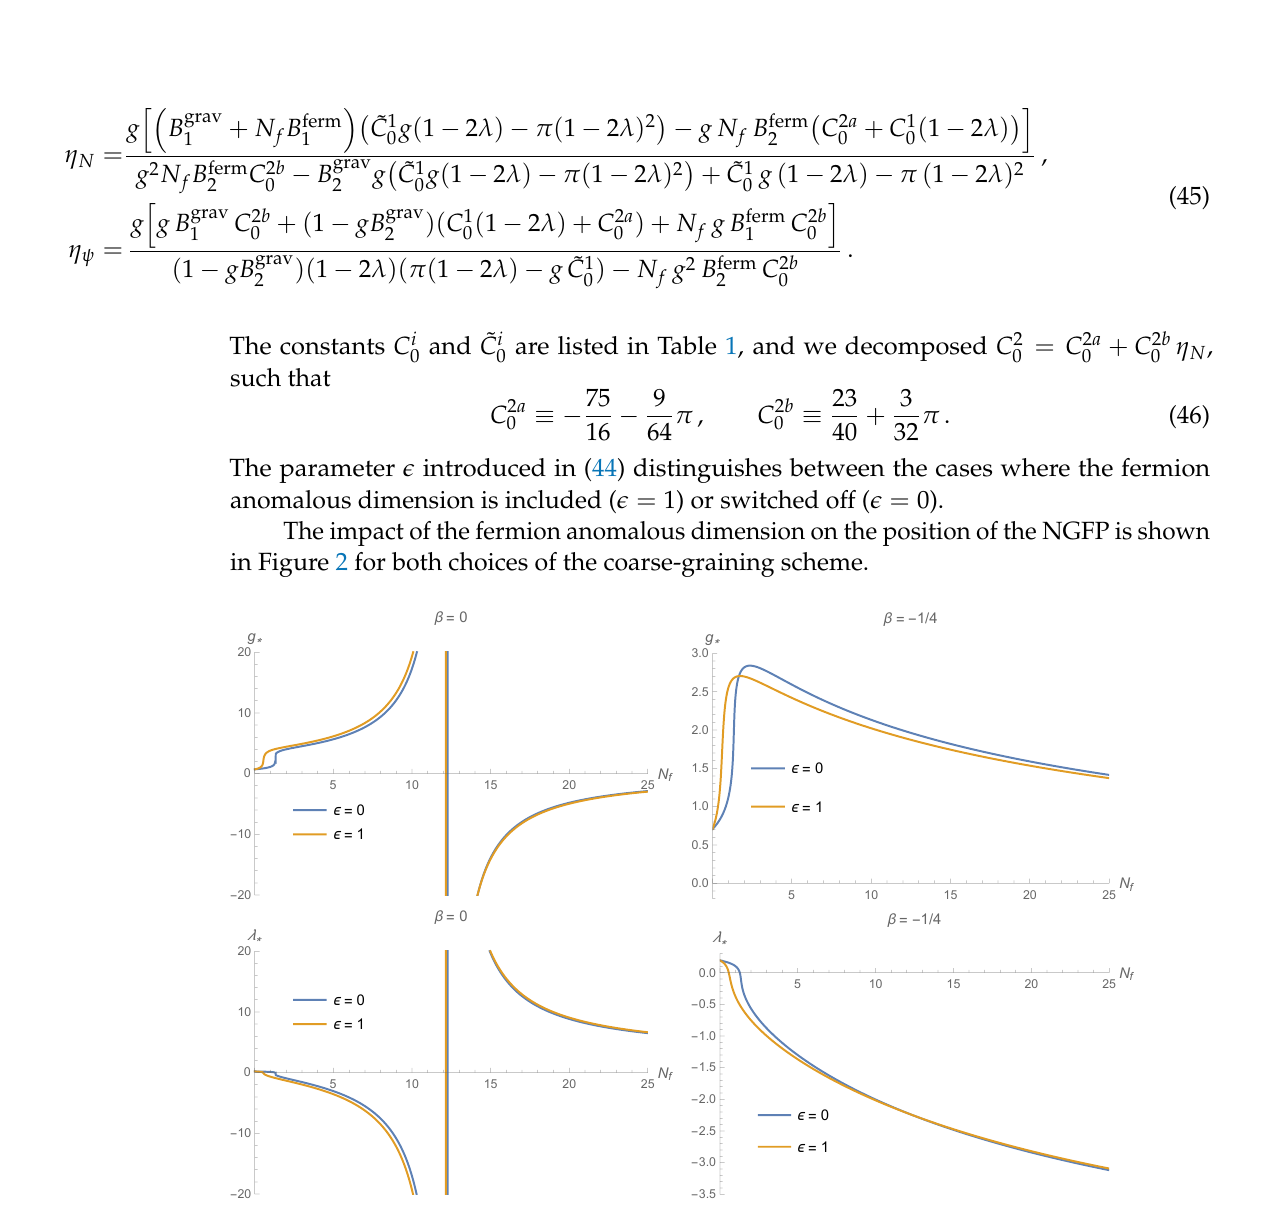
Figure 2. Corrections to the position of the NGFPs resulting from the inclusion of the fermion anomalous dimension ( (cid:101) = 1, orange lines). The position of the NGFP for η ψ = 0 is given by the blue lines. Notably, the corrections provided by the fermion anomalous dimension are small. They are most pronounced in small values of N f